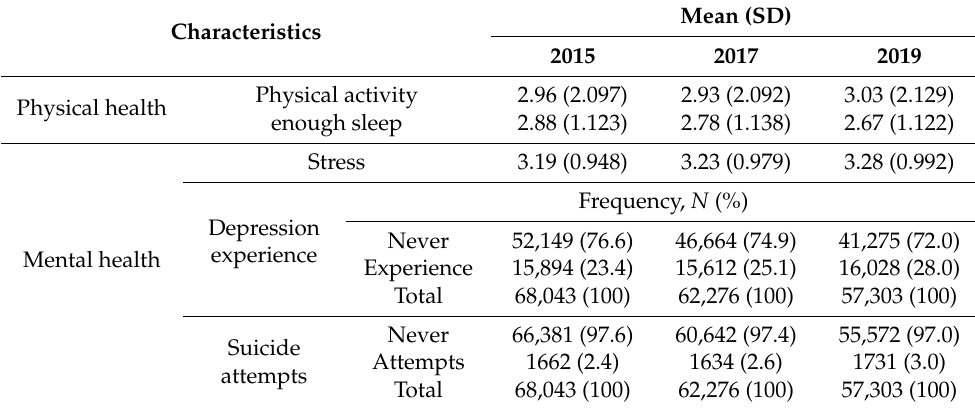
Table 3. Descriptive analysis results of physical and mental health.